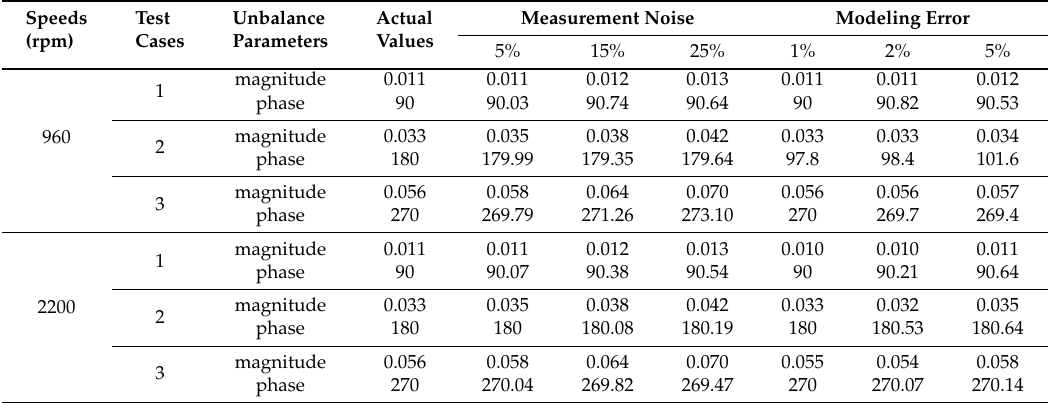
Table 8. Estimation of unbalance parameters in the paper machine’s tube roll with different types of modeling and measurement-based